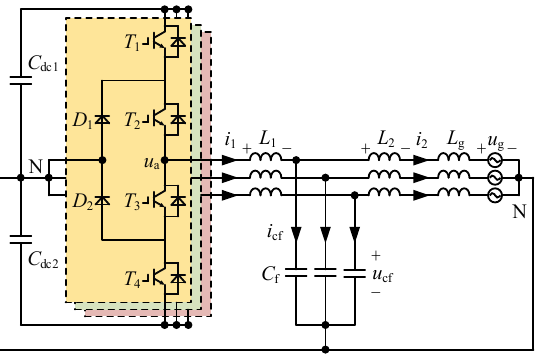
Figure 1. Main circuit of the three-phase LCL-type grid-connected inverter.